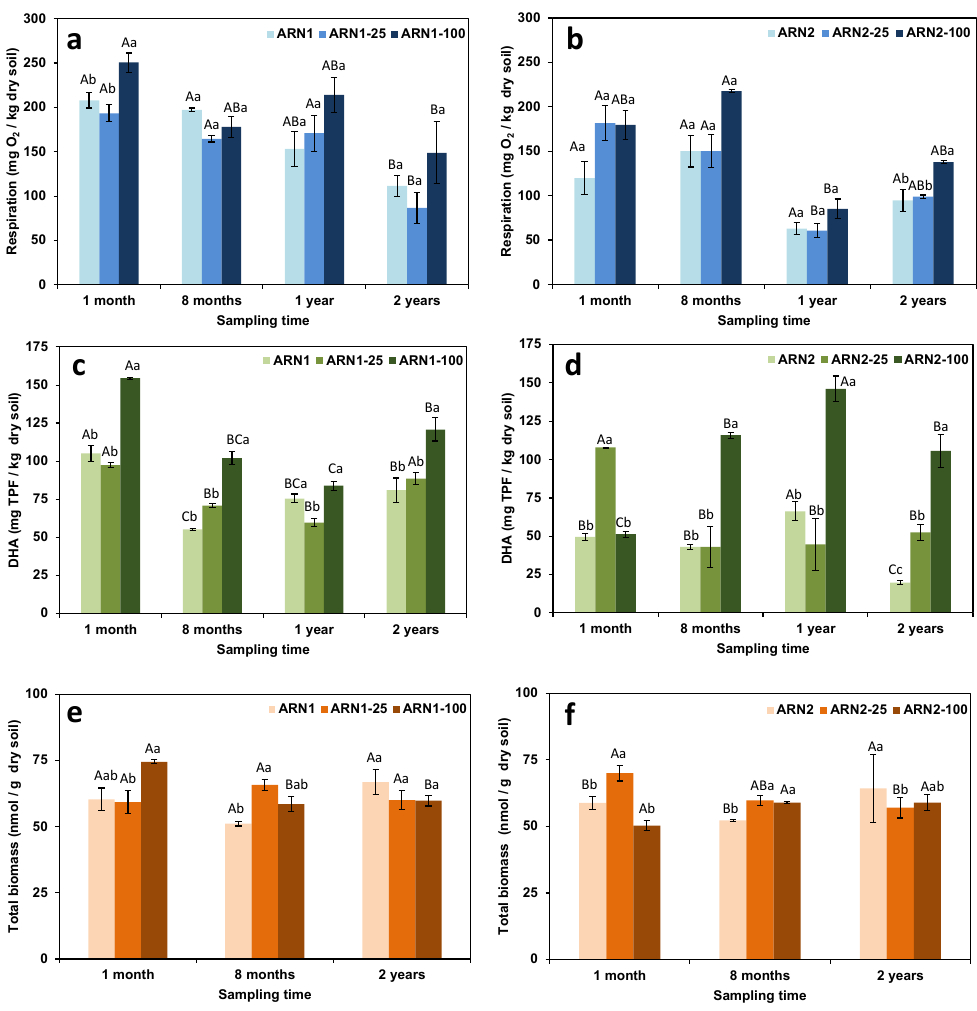
Figure 2. Soil microbial respiration measured by O 2 consumption ( a , b ), dehydrogenase activity— DHA ( c , d ), and total biomass ( e , f ) for ARN1 ( a , c , e ) and ARN2 ( b , d , f ) soils, unamended and SMS- amended at two rates at different sampling times after SMS application. Error bars represent the standard deviation of the mean. The lower-case letters above the bars denote significant differences ( p ≤ 0.05) between samples at each sampling time, and the upper-case letters above the bars denote significant differences ( p ≤ 0.05) for each sample at different sampling times.